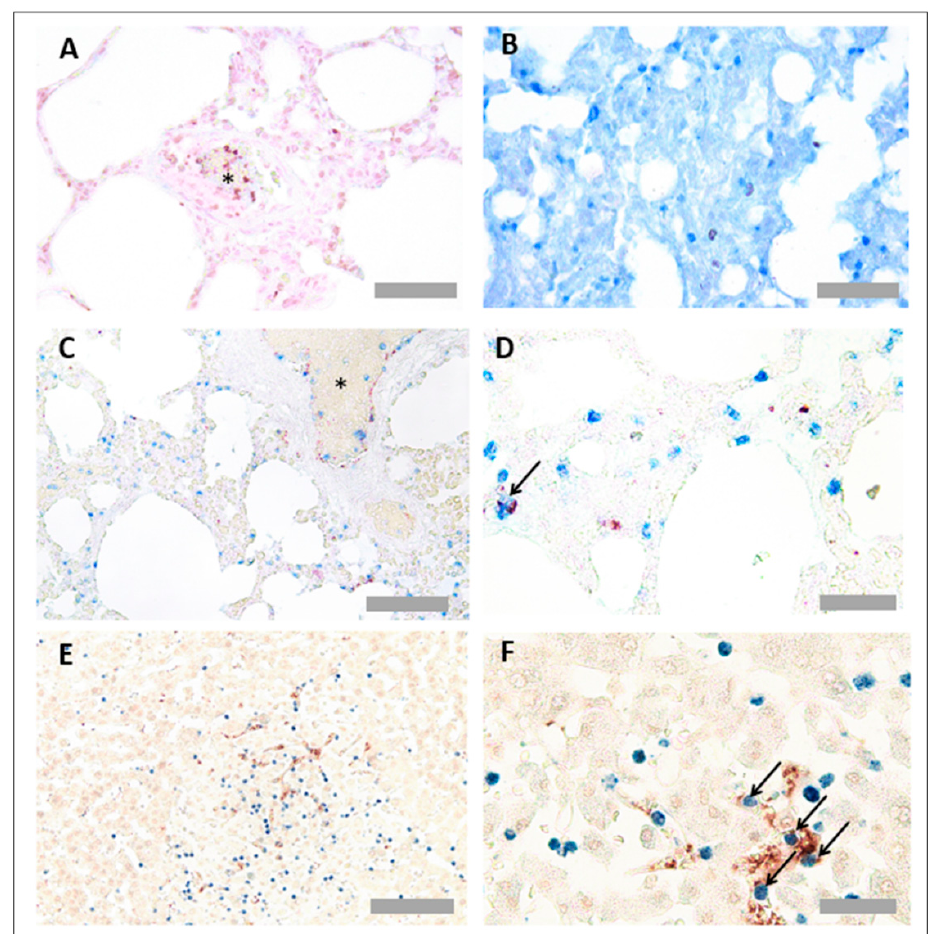
Figure 8. Platelet neutrophil complex multiplex immunohistochemistry in pig lung and liver tissues. Formalin fixed paraffin wax embedded (FFPE), and pig tissues were prepared and immunostained with anti-myeloperoxidase (MPO) antibody (ab9535, Abcam, Cambridge, UK) and anti-CD42b antibody (ab183345, Abcam, Cambridge, UK), prepared at 1/50 and 1/100 dilutions, respectively. Platelets appear red, and neutrophils appear blue. To ensure colour detection systems were functional, separate sections were immunostained with either anti-CD42b shown in red ( A ) or anti-MPO shown in blue. Representative images of neutrophil immunohistochemistry (anti-CD42b) in pig lung tissue ( C , D ) and pig liver tissue ( E , F ) are also shown. Asterisks denote blood vessels. Arrows point to PNCs. Scale bar = 50 μ m in Figures ( A , B ) (×40 objective), 100 μ m in Figure ( C , E ) (×20 objective) and 30 μ m in Figures ( C , E ) (×63 objective).